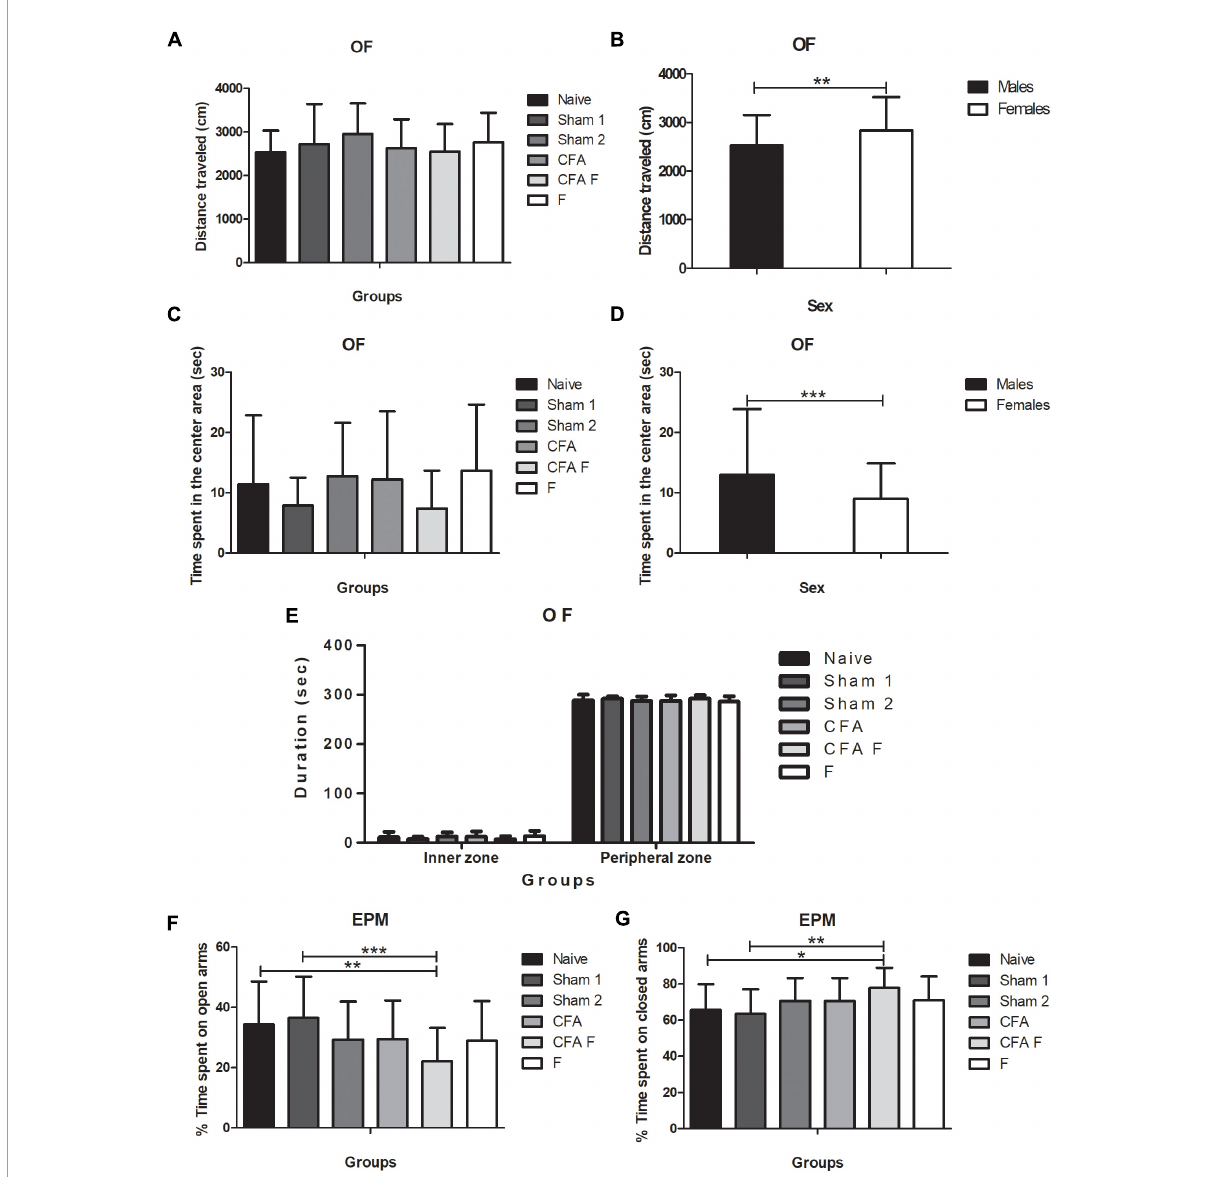
FIGURE5 (A) No differences in the distance traveled were observed among the groups. (B) Females traveled a longer distance than males ( p = 0.01). (C) No significant effect was observed for the duration in the inner zone among groups ( p = 0.11). (D) The males spent more time than females in the central area ( p = 0.01). (E) No significant differences in the duration (sec) in the inner and outer zones were observed. (F) CFA + F group spent less time in the open arms in the EPM when compared to Naïve ( p = 0.03) and Sham 1 ( p = 0.005). (G) CFA + F spent more time in the closed arms in the EPM when compared to Naïve ( p = 0.028) and Sham 1 ( p = 0.005). OF, open field; EPM, elevated plus maze (* p < 0.05; ** p < 0.01; *** p < 0.001).